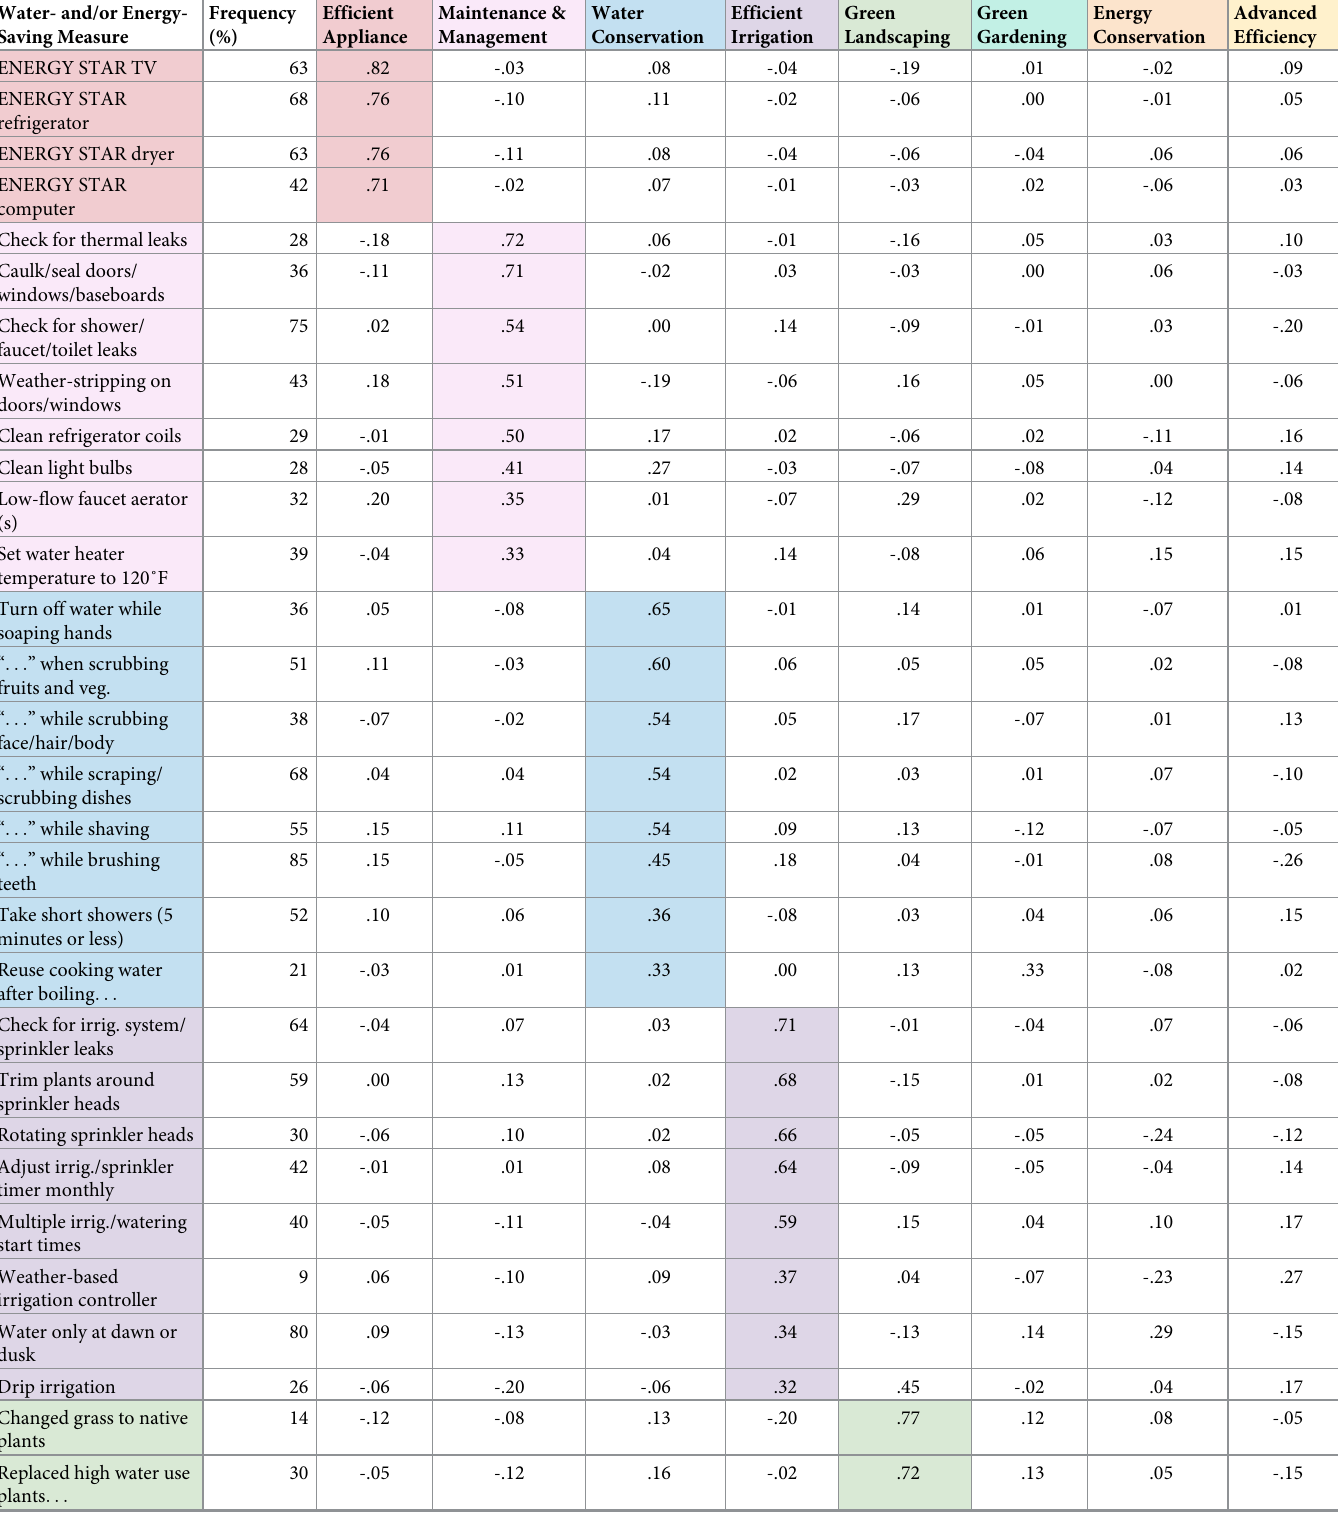
Table 3. PCA results: Factor loadings of each measure onto each measure